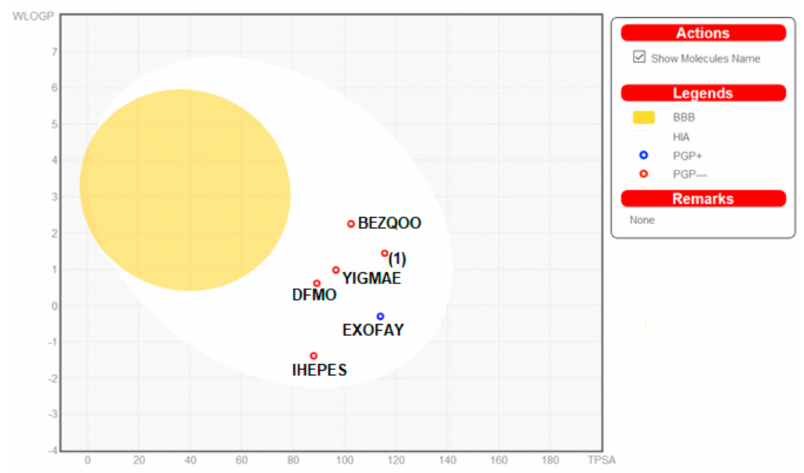
Figure 12. Predicted BOILED-Egg diagram of the selected compounds, from SwissADME web